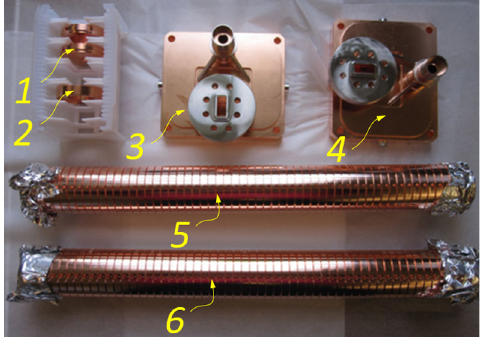
FIG. 7. All components are ready for the final brazing: 1: matching cell; 2: joining ring; 3, 4: brazed coupler assemblies; 5, 6: diffusion bonded half-length